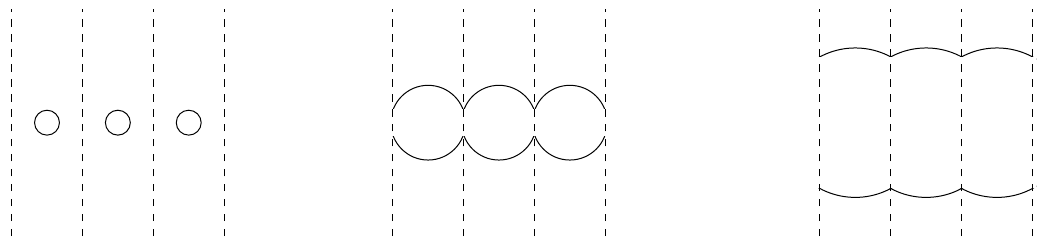
Figure 3. Entangling regions of varying radius on R × S 1 . The S 1 direction runs horizontally and its identifications are denoted by the dashed vertical lines. Figure reproduced from